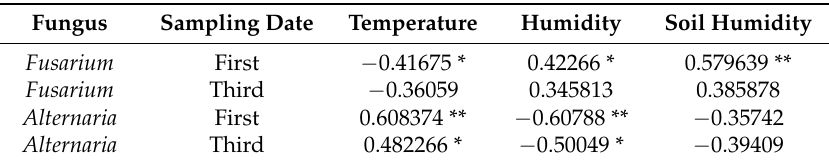
Table 4. Spearman correlations between measured genetic abundances and environmental parameters